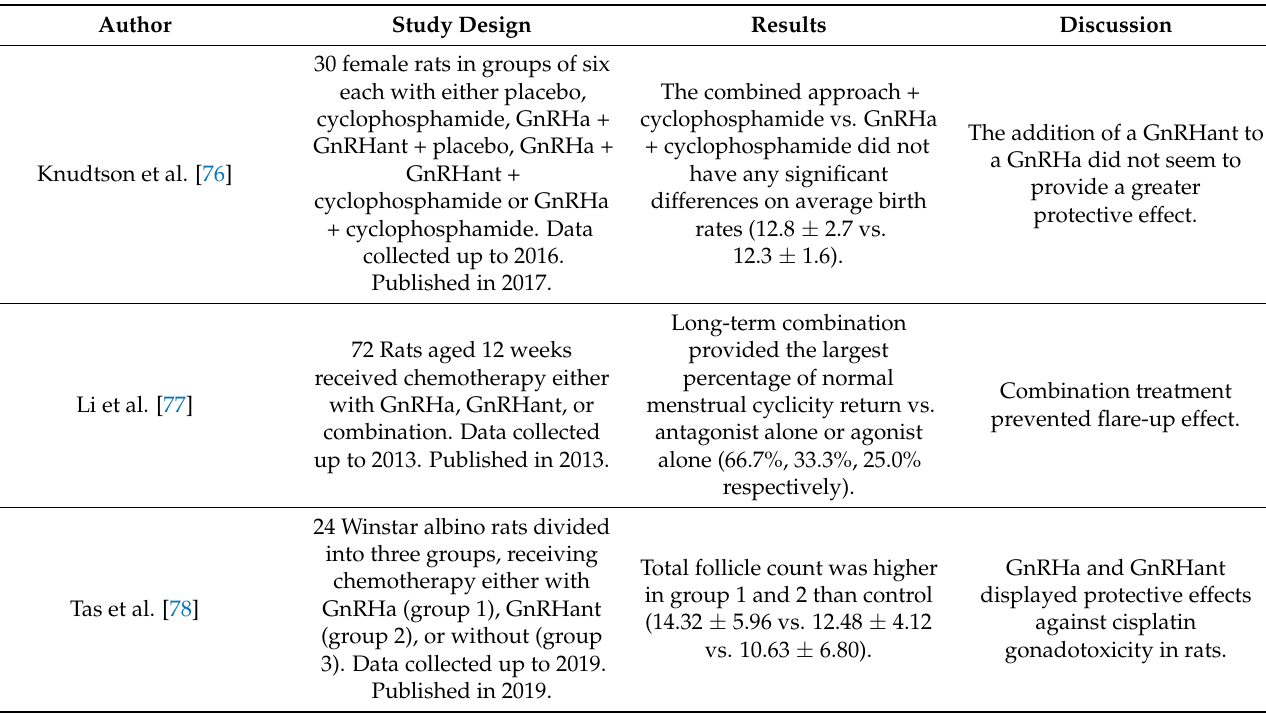
Table 4. Combination of GnRH agonists and antagonists and fertility preservation post cancer